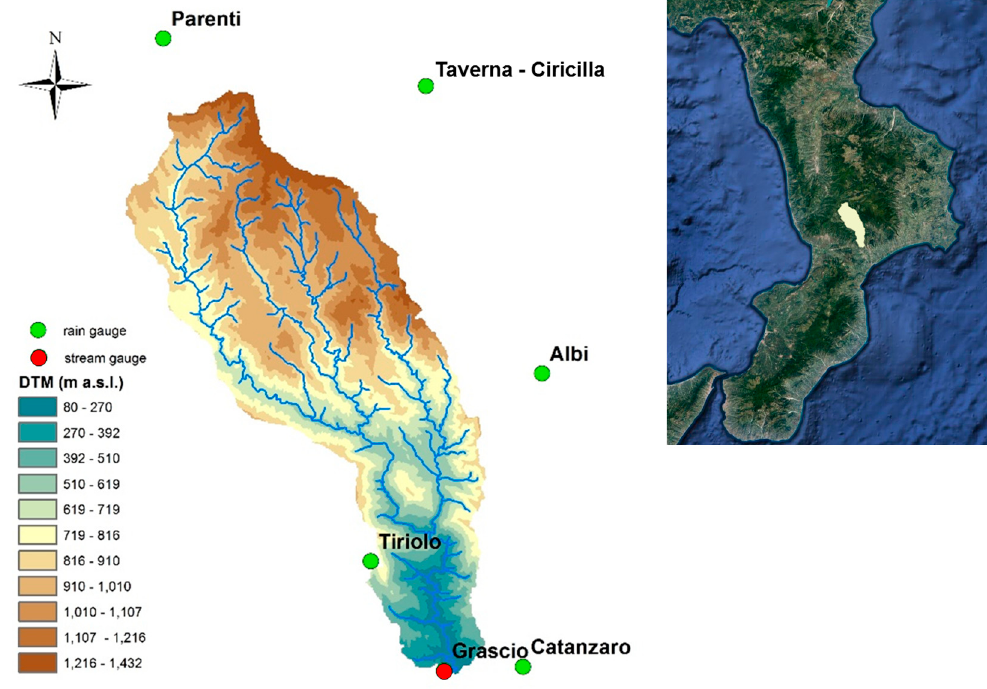
Figure 1. The basin of Corace at Grascio: the green dots represent the rain gauges, while the red dot is the stream gauge. Table 1. Station network referred to Corace at Grascio.